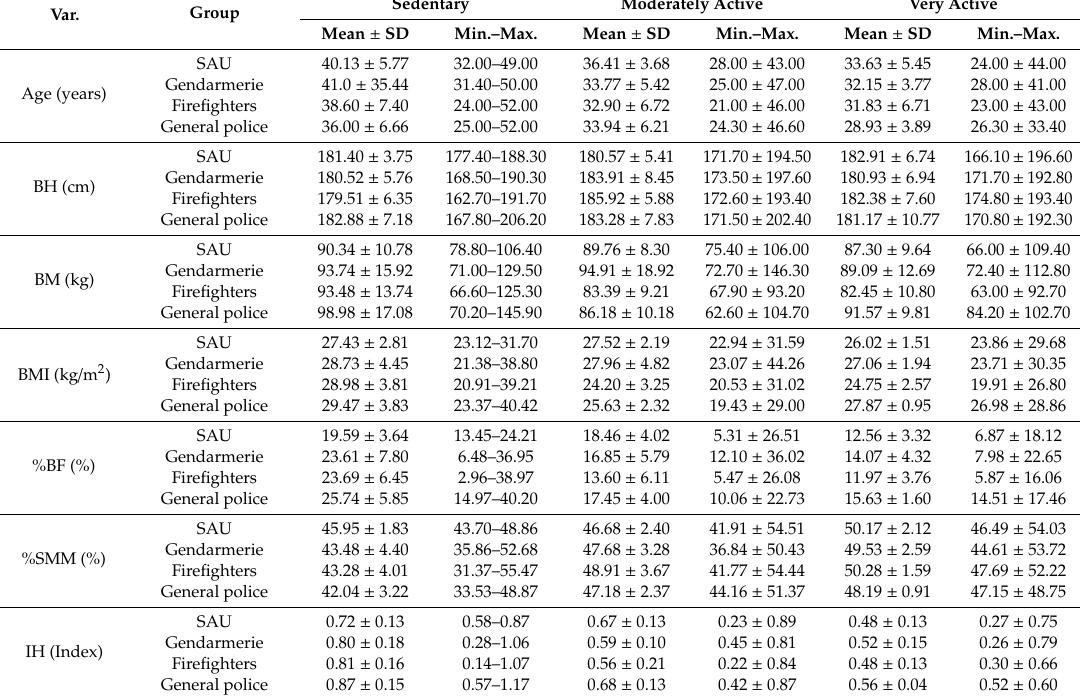
Table 1. Descriptive statistics for study participants (N =